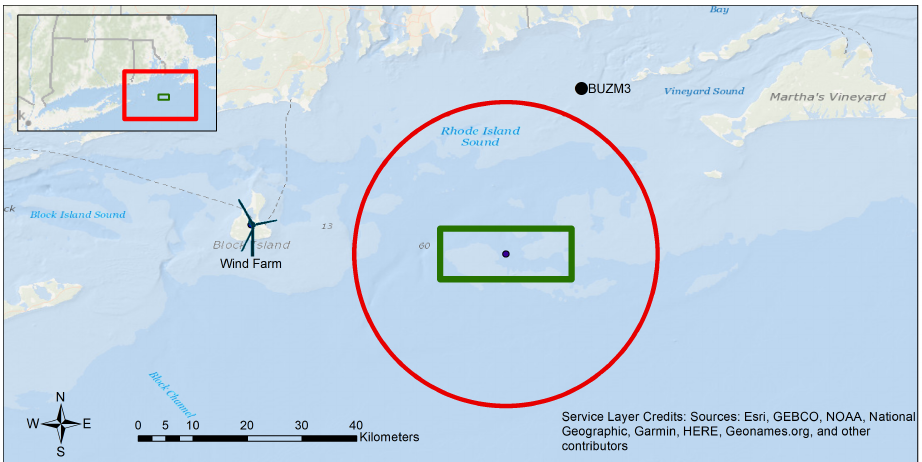
Figure 9. Map of locations of BUZM3 station, wind farm and target area (green rectangle). The red circle represents R p 25 of the center of the target area.